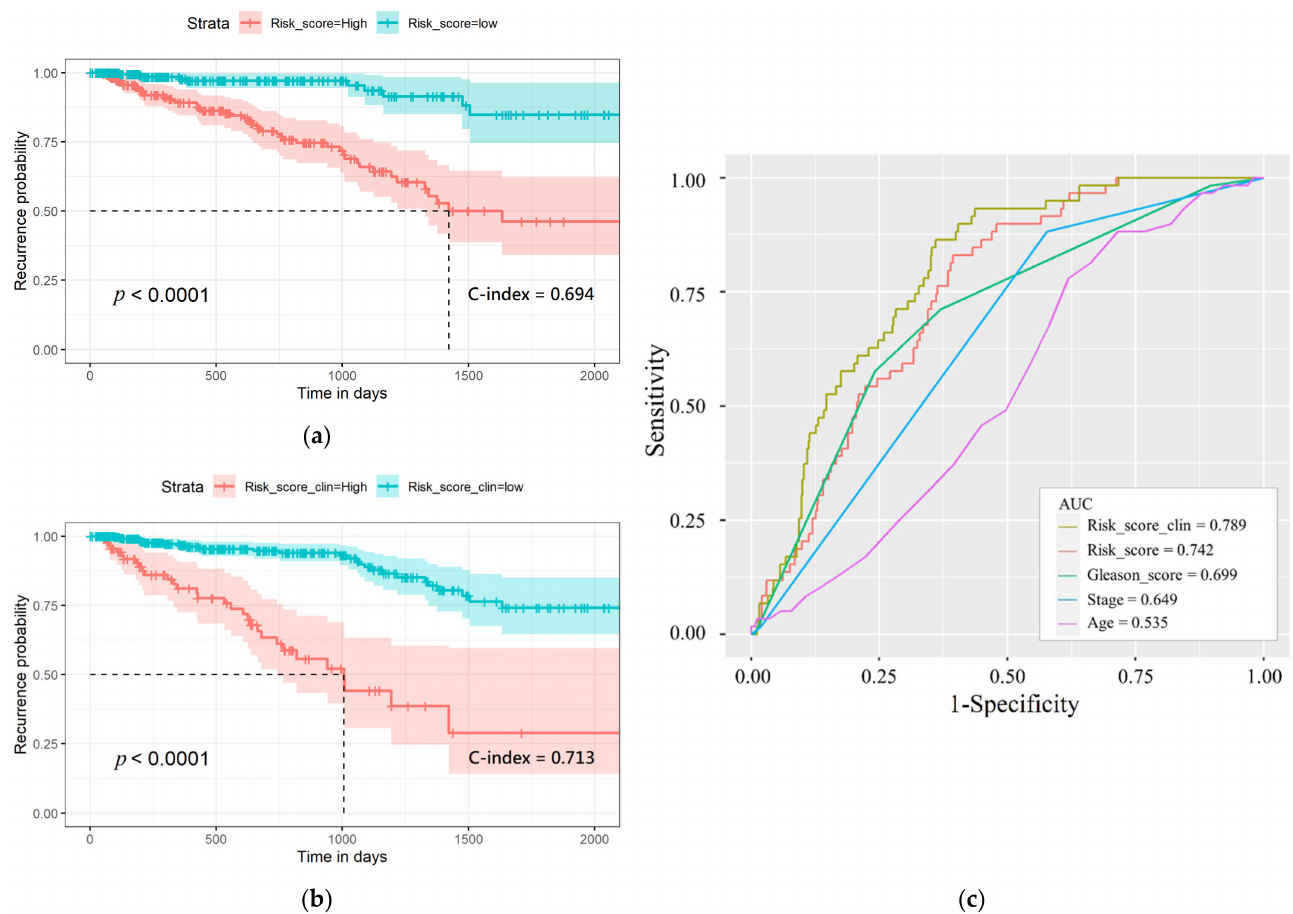
Figure 6. ( a ) Recurrence-risk curves according to high and low risk score. ( b ) Recurrence-risk curves according to risk score combined with clinical information. ( c ) The 5-year survival receiver operating curve of risk score and other clinical data and their